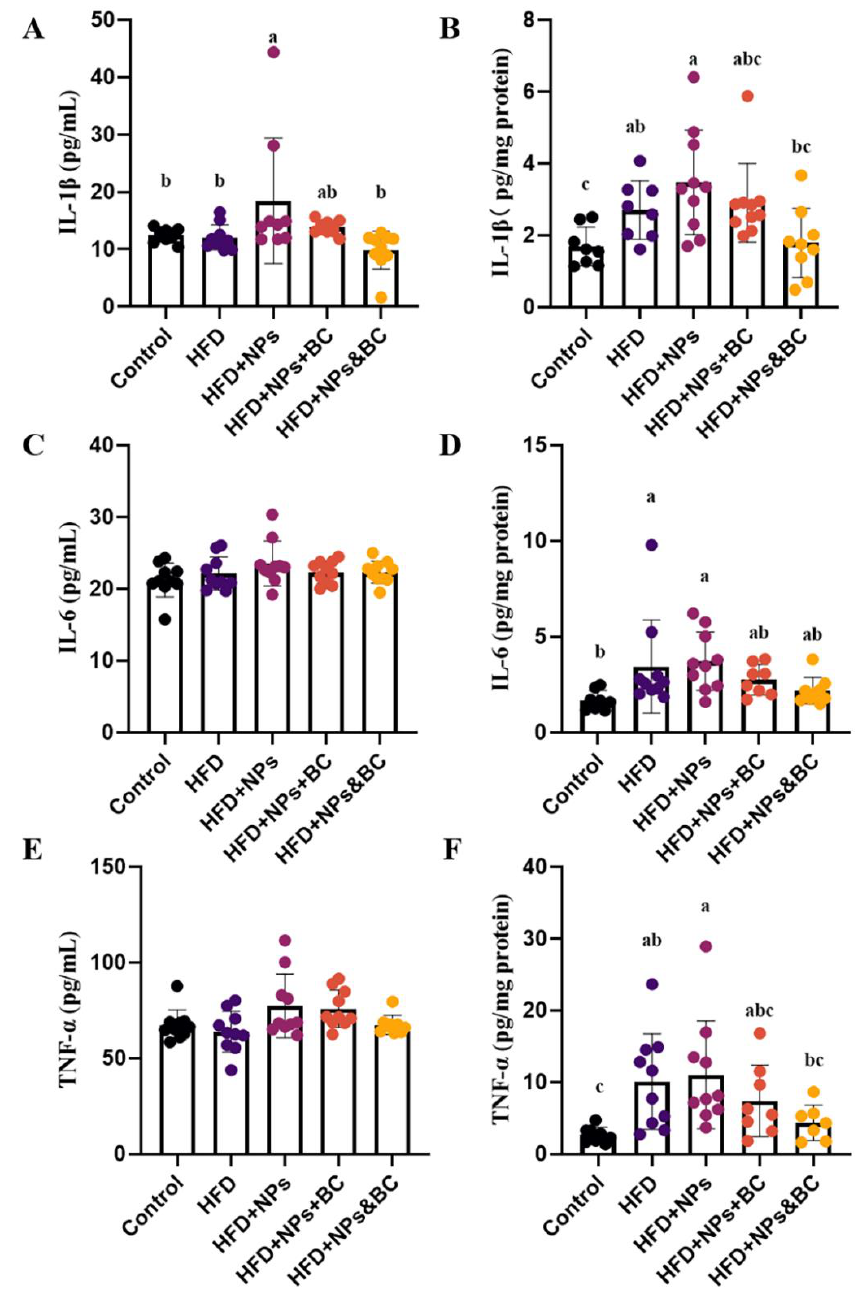
Figure 2. The effects of pro-inflammatory cytokine levels on serum and colon tissues in mice. ( A ) The IL-1 β levels in serum, ( B ) the IL-1 β levels in colon tissues, ( C ) the IL-6 levels in serum, ( D ) the IL-6 levels in colon tissues, ( E ) the TNF- α levels in serum, and ( F ) the TNF- α levels in colon tissues. The different letters represent significant differences among groups ( p < 0.05).